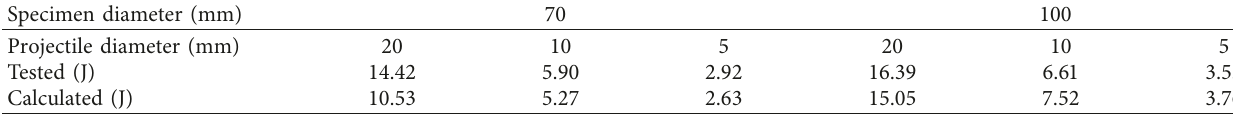
Table 7: Failure energy of the BFRP plate under static indentation.